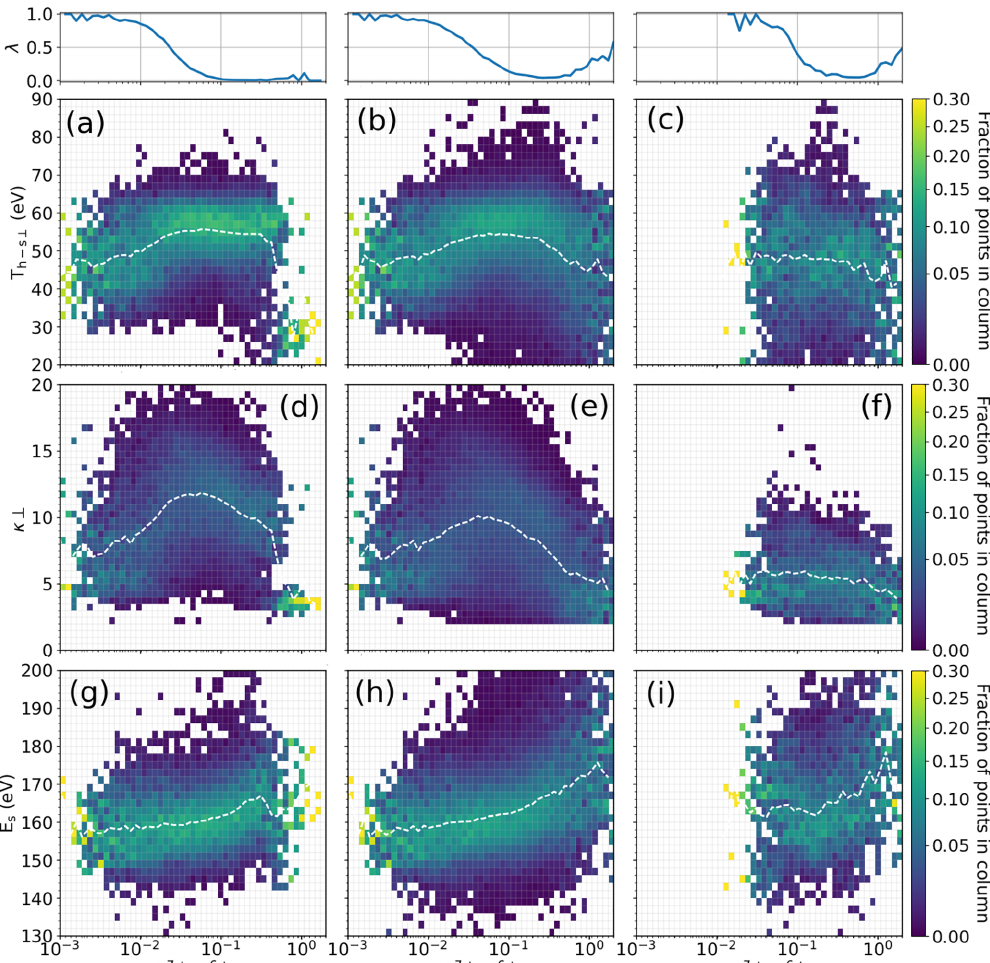
Figure 7. Histogram plots for T h–s ⊥ (a–c) , κ ⊥ (c–f) and E s (g–i) against O 7 + / O 6 + . Panels (a, d, g) are composed of data taken during the lower quartile period of sunspot number, (b, e, h) the middle two, and (c, f, i) the upper. The plots are normalised for each box by the number of points in that bin of O 7 + / O 6 + . For each column of plots, the small top panel above shows λ , the fraction of solar wind samples above 500kms − 1 (fast solar wind) per bin of O 7 + / O 6 + . For T h–s ⊥ , we note a weak upward trend in (a) which is not found in (c) , likely as O 7 + / O 6 + in (c) does not extend to sufficiently low values. Panel (b) shows a similar increase in T h–s ⊥ at low O 7 + / O 6 + values as (a) does, and also a drop-off at high O 7 + / O 6 + values as in (c) . T h–s ⊥ extends down to the pre-defined limit of halo temperature, indicating likely drop-outs of the halo at large O 7 + / O 6 + . For κ ⊥ , in both (d) and (e) we observe a broadly spread, upwards trend in the low-O 7 + / O 6 + regions ( < 0 . 02), which then inverts to become a downwards trend at higher values. In (f) , we see only high-O 7 + / O 6 + values and see κ ⊥ decrease gradually. There is a degree of agreement between these trends and those of T h–s ⊥ above. For E s , a weak upward trend is found in (g) , which appears to sharply fall off at higher O 7 + / O 6 + ( > 0 . 2). This may be due to a lack of samples at high O 7 + / O 6 + , however. Panel (i) also shows a weak positive trend, but this is far less smooth as (i) is made up of fewer samples than (g) or (h) . Panel (h) shows a continuous positive trend through all available O 7 + / O 6 + samples. The trend increases more sharply as O 7 + / O 6 + increases.